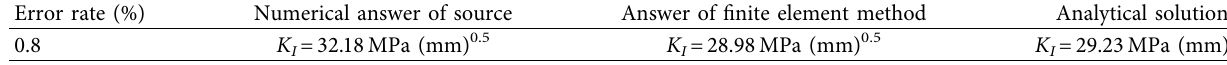
Table 11: Comparing results for the plate including edge crack.